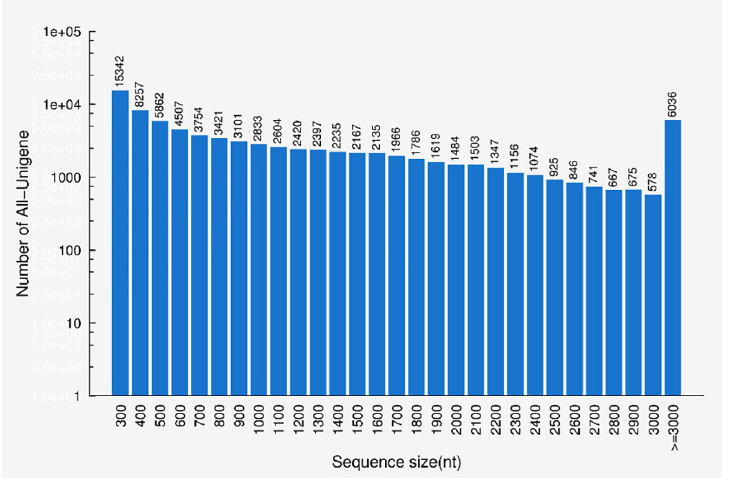
Fig 1. Length distribution of the assembled contigs and